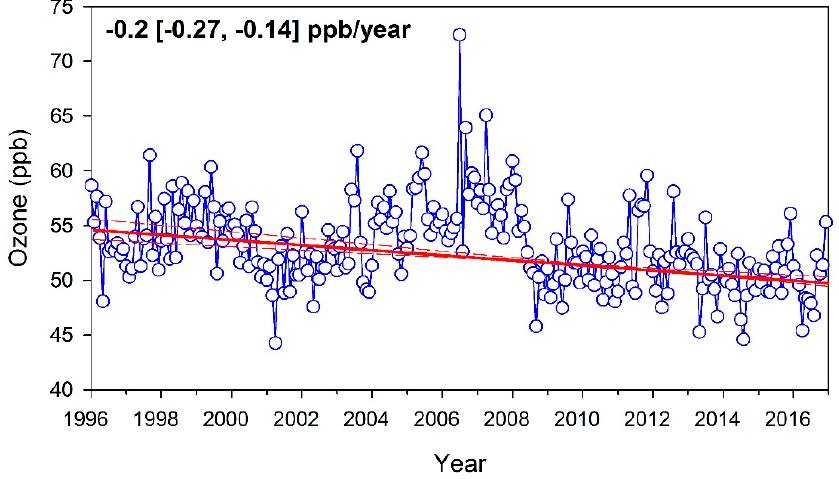
Figure 7. Time series of deseasonalized monthly O 3 average values for CMN, together with the trend estimates (solid lines) and the 95% confidence intervals for the trends (dashed lines). At the top of the plot, the trend value is reported, together with the 95% confidence intervals in the slope.